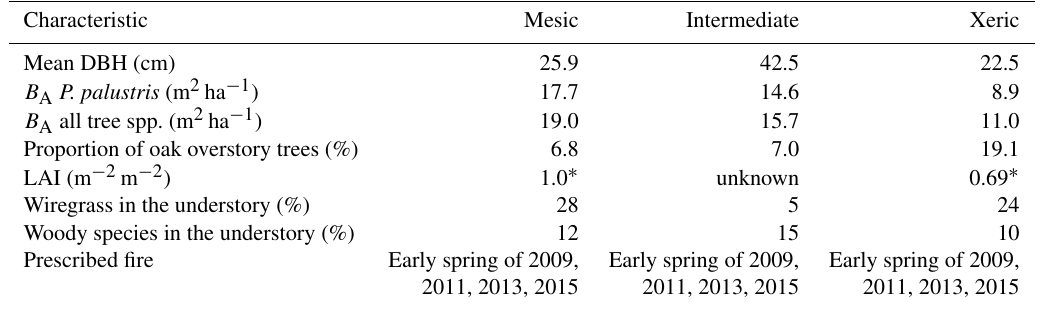
Table 1. Stand characteristics at the mesic, intermediate and xeric sites at the Joseph W. Jones Ecological Research Center, Newton, GA,